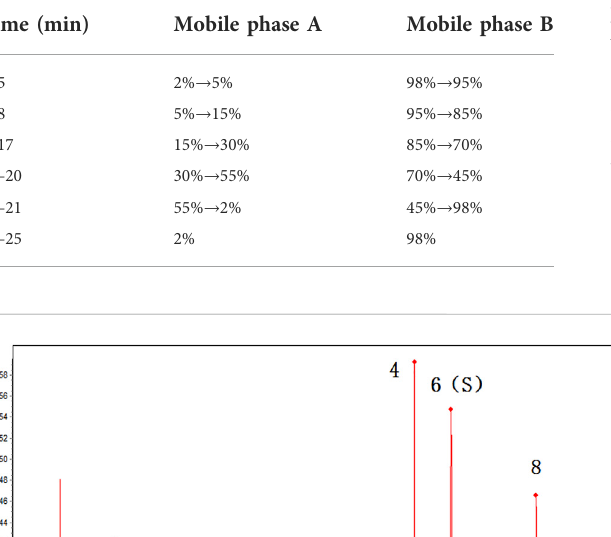
TABLE 3 UPLC gradient elution process.